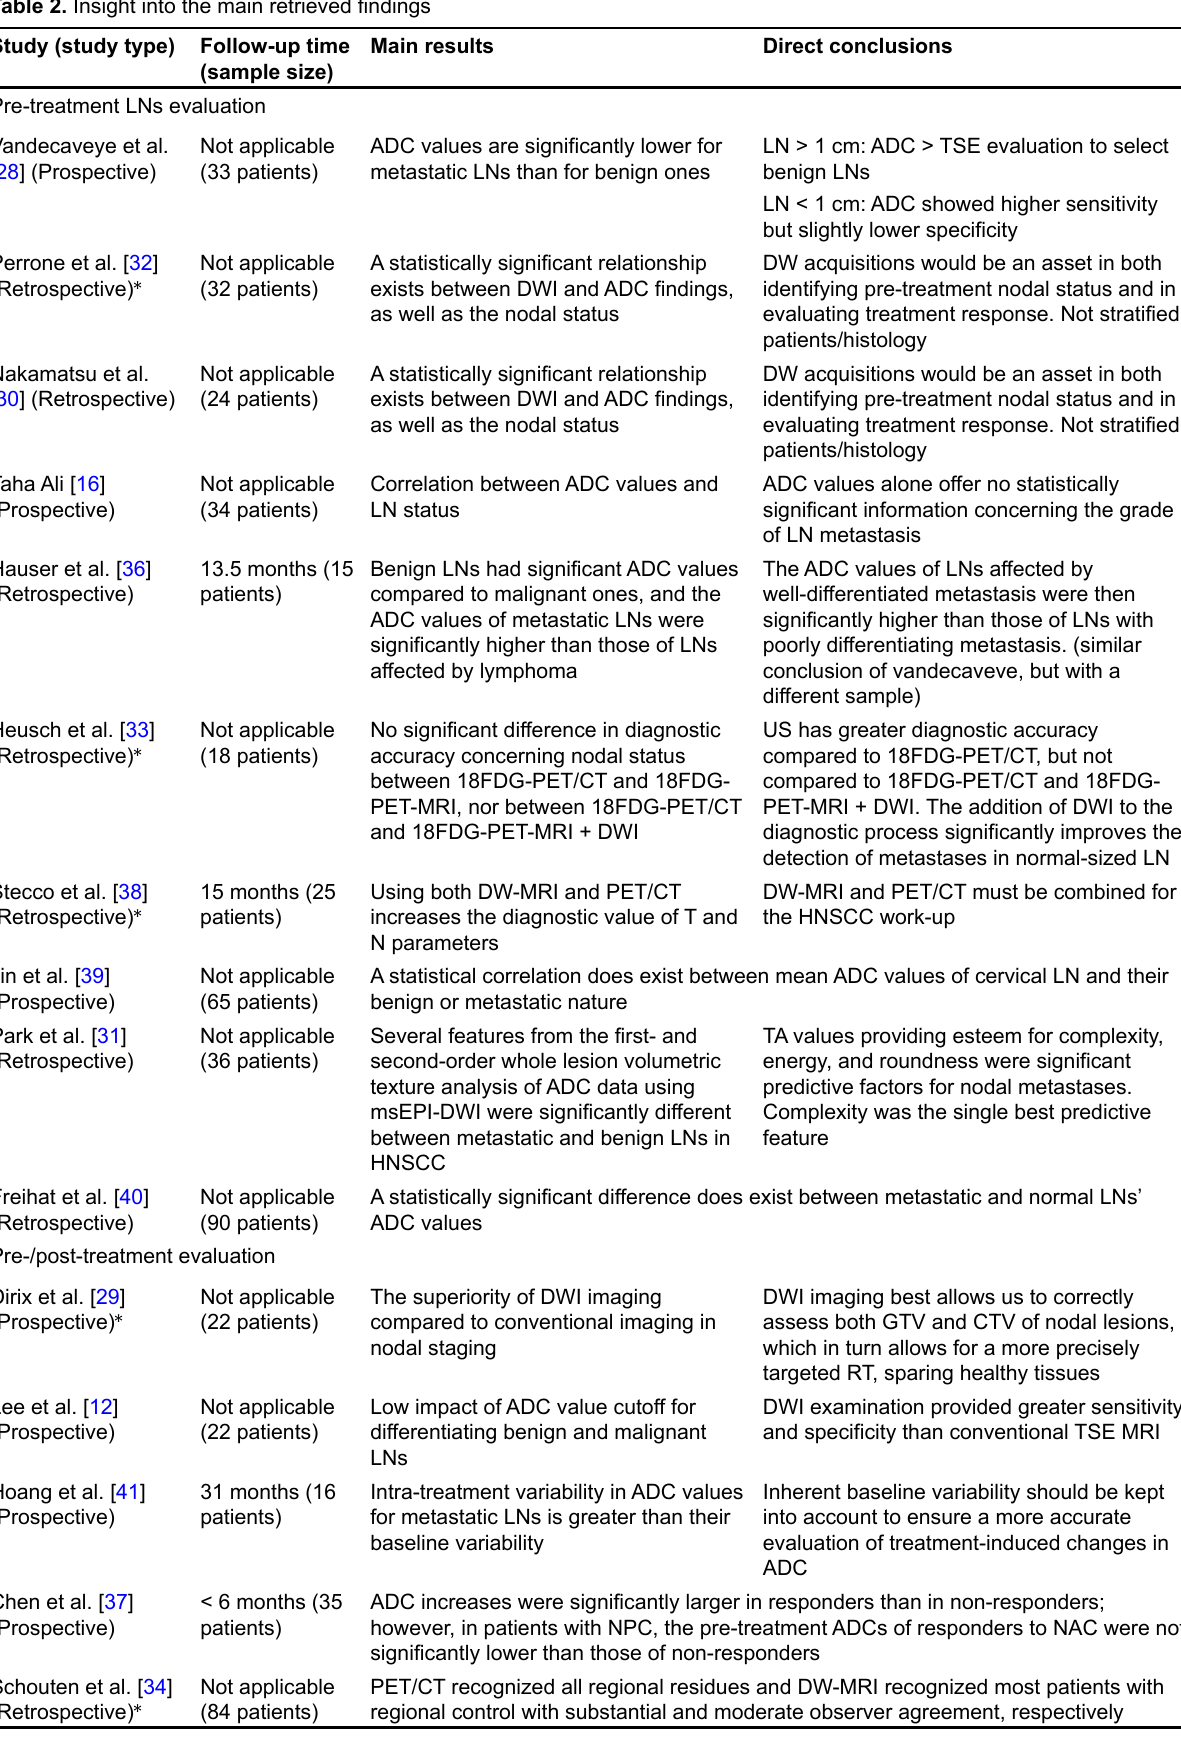
Table 2. Insight into the main retrieved findings Study (study type) Follow-up